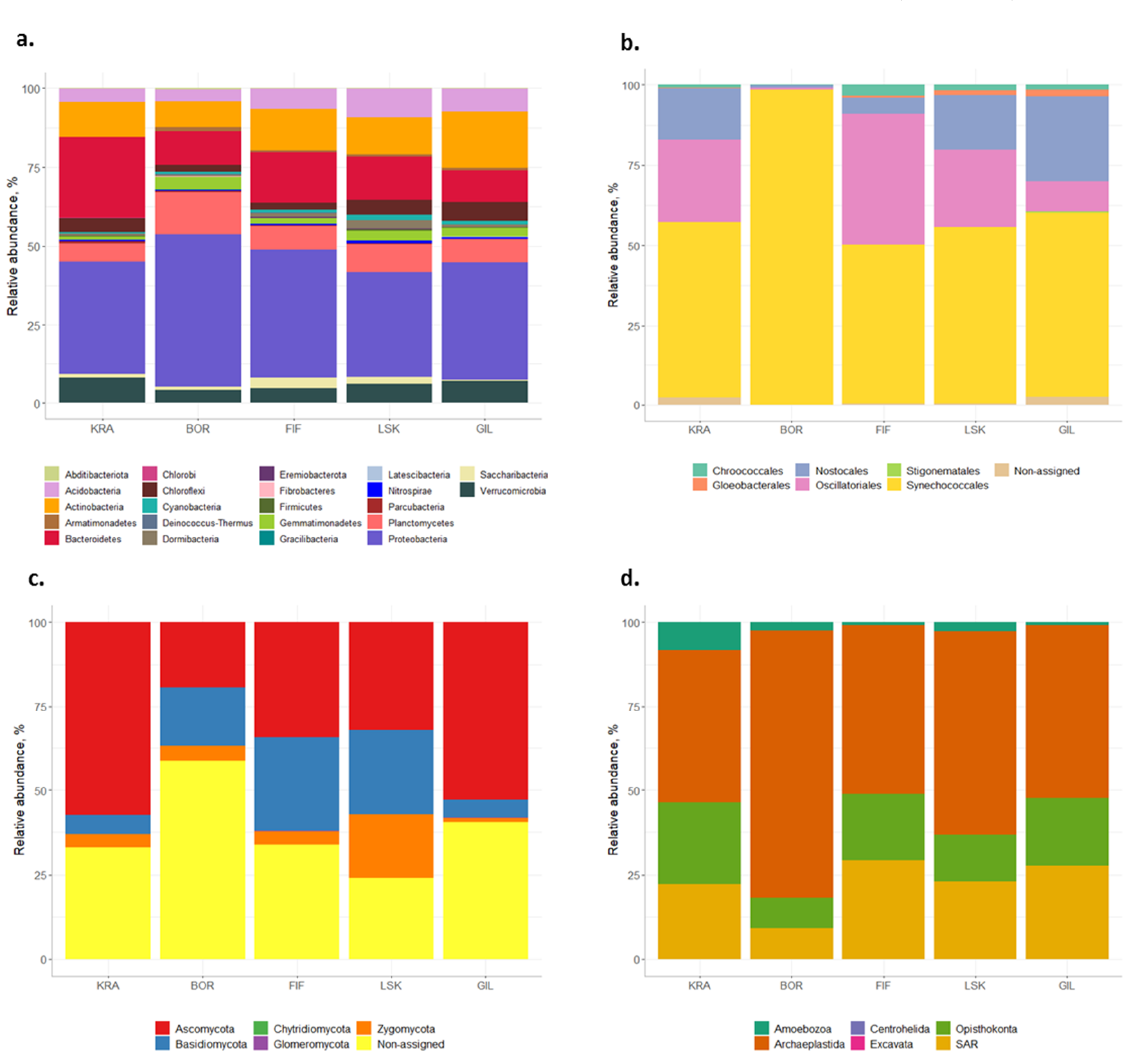
Figure 1. General microbial profile of Icelandic biocrusts. The figures show the relative abundances based on the read numbers obtained by amplicon sequencing: ( a ) bacterial phyla; ( b ) cyanobacterial orders, ( c ) fungal phyla, and ( d ) eukaryotic clades. KRA—Krákunes, BOR—Borgarfjarðarbraut, FIF—Fiflholt, LSK—Litla-Skard, GIL—Giljar.